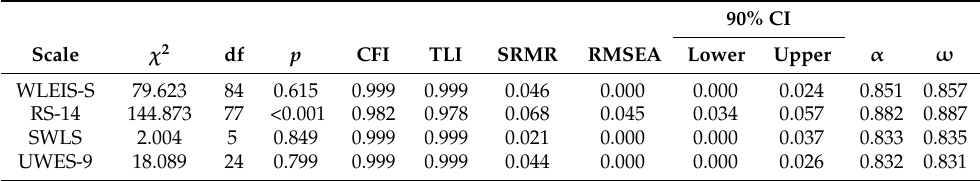
Table 1. CFA Results and Reliability for the Different